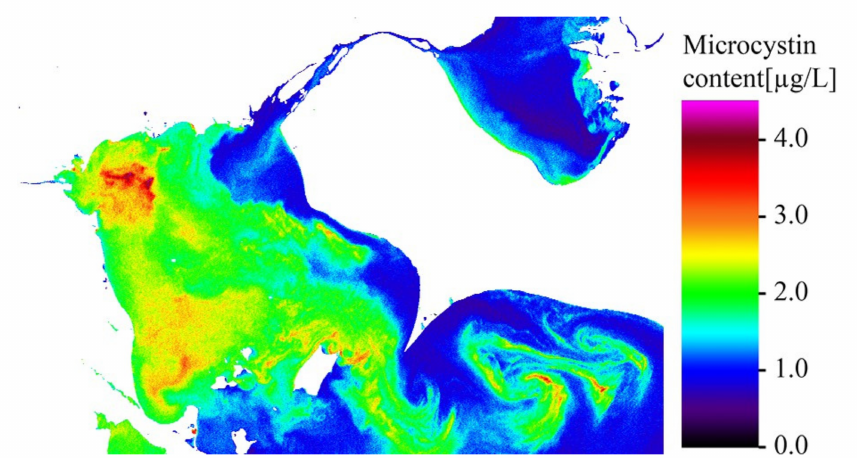
Figure 7. Map of microcystin content derived from phycocyanin content derived from HICO im- ages. Not oriented to better fit the screen in the app (see Section 2.2) (Data source: NASA Ocean Color portal).